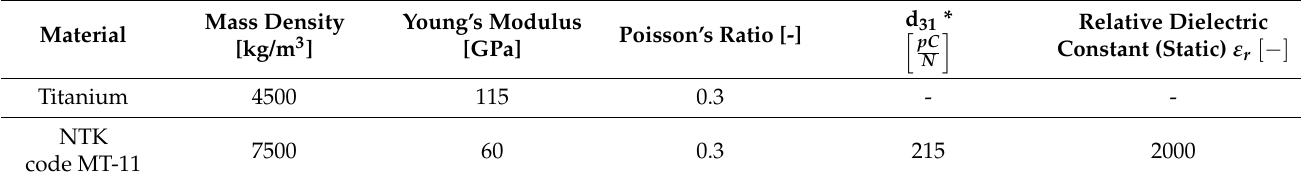
Figure 9. Bimorph piezoelectric beam used in the experimental setup: RS 285-784, RS Component. Dimensions: length 15 mm, width 1.5 mm, and thickness 0.6 mm. Table 4. Physical properties of the involved materials ε 0 = 8.854 × 10 − 12